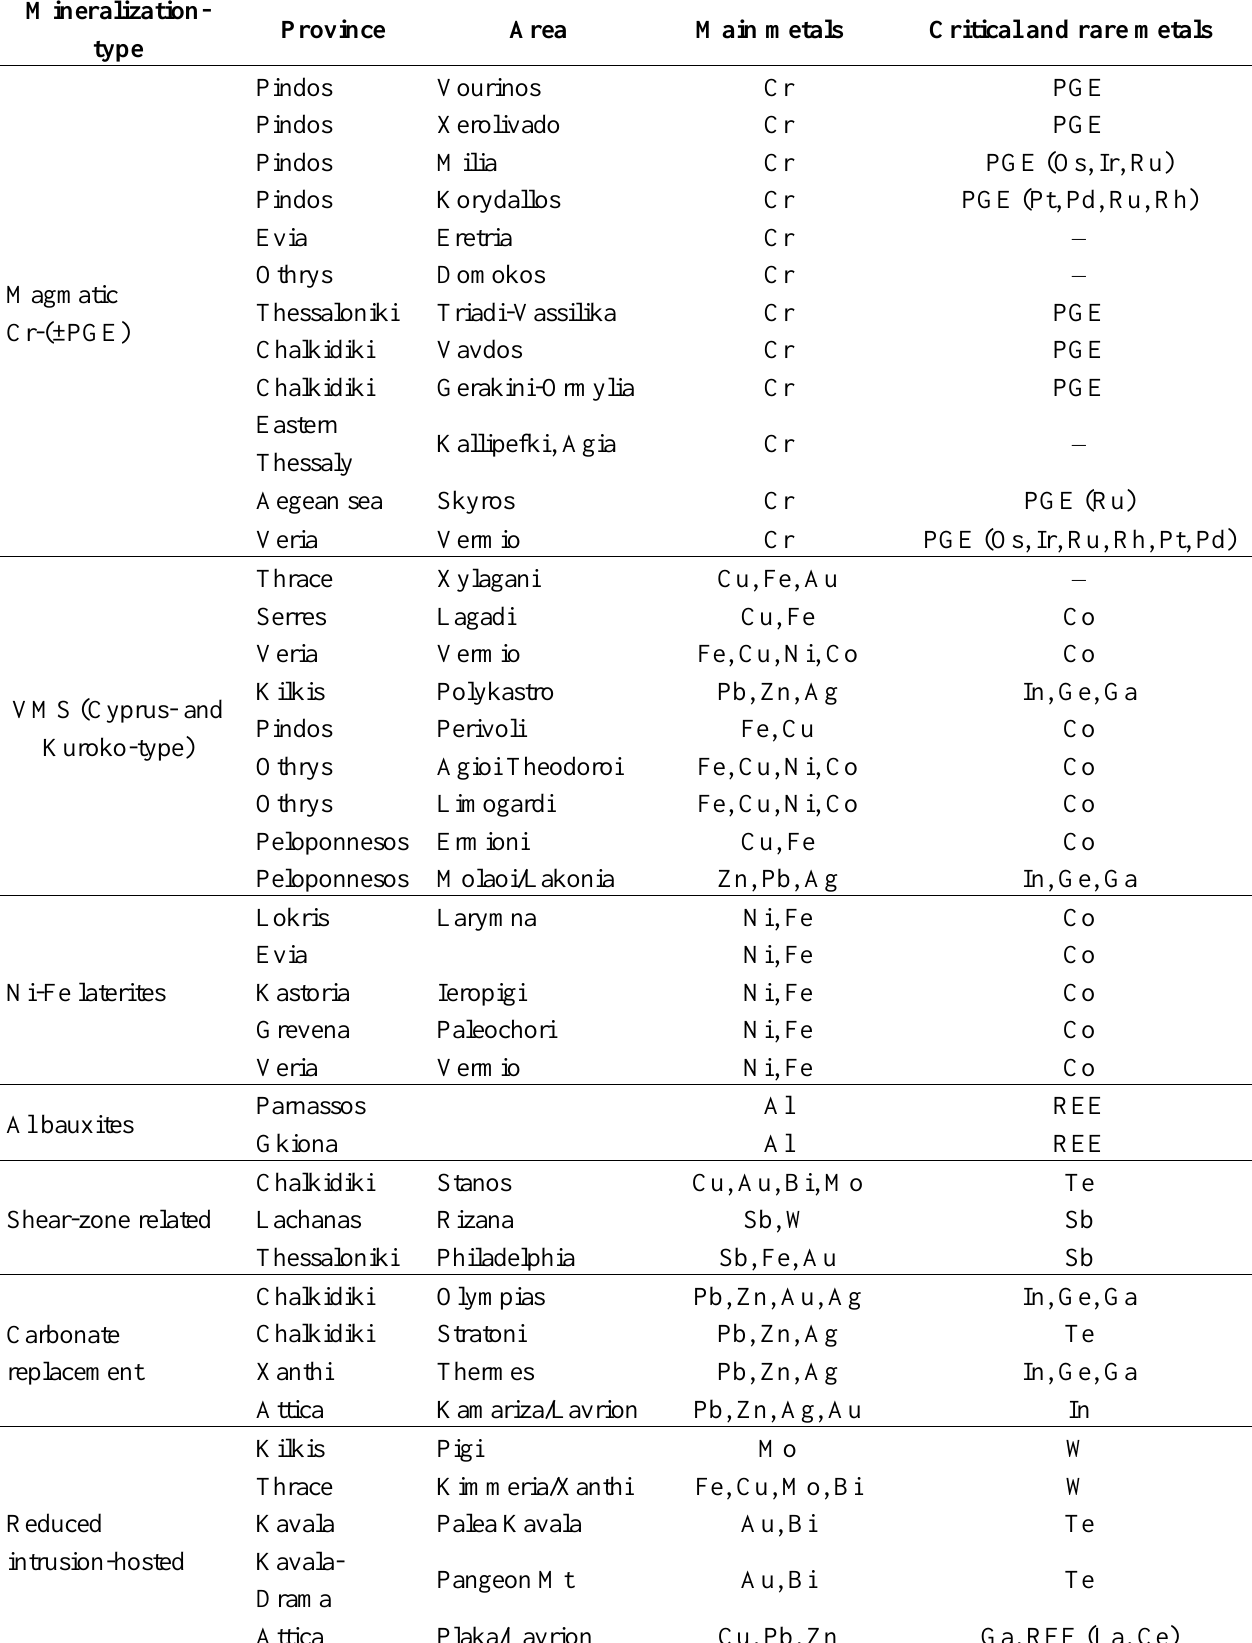
Table 1. Characteristics of critical- and rare metal-bearing mineralization in Greece (data sources in